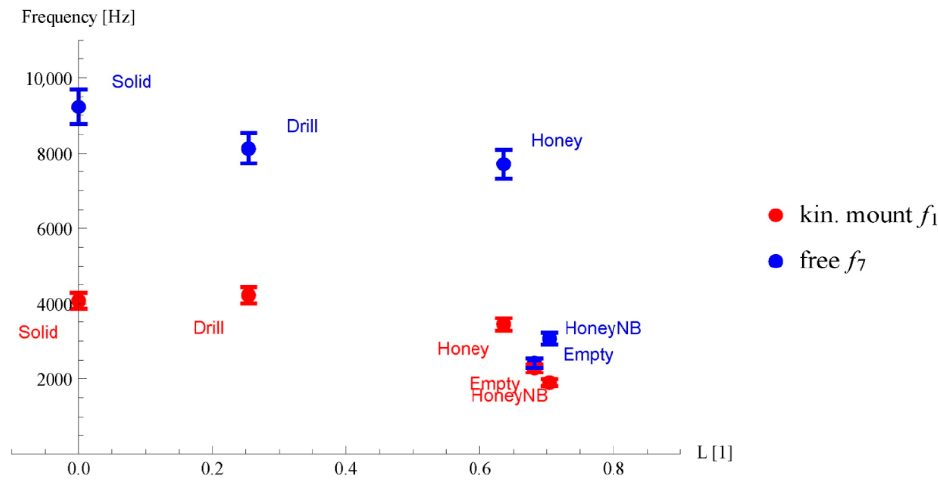
Figure 17. Mass reduction factor versus modal frequency of several design models [33]. By summarizing the experience, Songnian Tan et al. from Changchun Institute of Op- tics, Fine Mechanics and Physics (CIOMP) fabricated an Al mirror based on SLM technology in 2020 [37]. The mirror is a flat metal mirror with the dimensions of 67 mm × 50 mm used as a fast-steering mirror (FSM) in the infrared optical system. They adopted a rela- tively conventional design method, as shown in Figure 18. The final lightweight rate reached 43.7% while meeting the internal connectivity constraints. After AM prefabrica- tion, λ /10 ( λ = 632.8 nm ) of the surface shape was achieved through CNC machining and optical processing, which meets the application requirements of the infrared level.